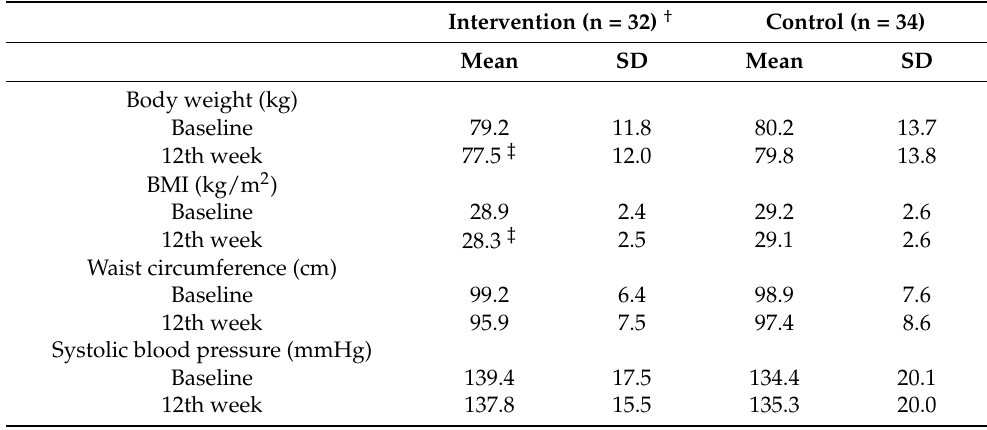
Table 2. Body weight and other components of metabolic syndrome at baseline and the 12th week among participants with complete